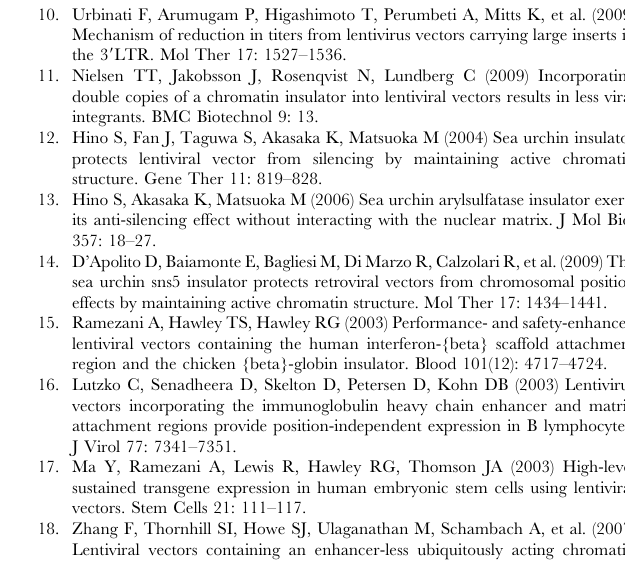
Figure S6 GATA1 and CBP occupancy at the endogenous LCR HS4. Chromatin from GLOBE- and G-GLOBE-trans- duced HEL was immunoprecipitated with antibodies against GATA1 and CBP and control rabbit IgG. The endogenous LCR HS4 served as a positive control for GATA1 and CBP binding in both GLOBE- and G-GLOBE-transduced bulk populations (n =2). Error bars represent SEM. Figure S7 Similar acetylation levels at the control AldolaseA gene. ChIP assay was performed as described in the legend to Figure 7. The levels of histone H3 and H4 acetylation are comparable at the positive control region from Aldolase A gene in both GLOBE- and G-GLOBE-transduced HEL cells (n =4). The results are averages of 4 independent experiments. Error bars represent SEM. Figure S8 Analysis of histone methylation patterns at the 5 9 LTR and at the b -globin promoter-HS2 region of GLOBE and G-GLOBE vectors. ChIP assay was carried out in GLOBE- and G-GLOBE-transduced HEL cells using antibodies against mono- and trimethyl-H3K4 (H3K4me1 and H3K4me3) and against trimethyl-H3K9 and trimethyl-H3K27. qPCR was performed to amplify the 5 9 LTR (A) and the b -globin promoter- HS2 region (B). Bars denote averages of 4 independent experiments. Error bars represent SEM.